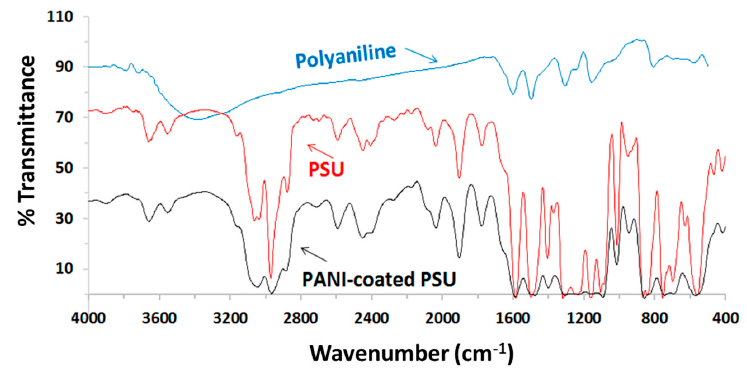
Figure 1. FTIR spectra for pure PANI in the acid form, pure PSU and PANI-coated PSU in the acid